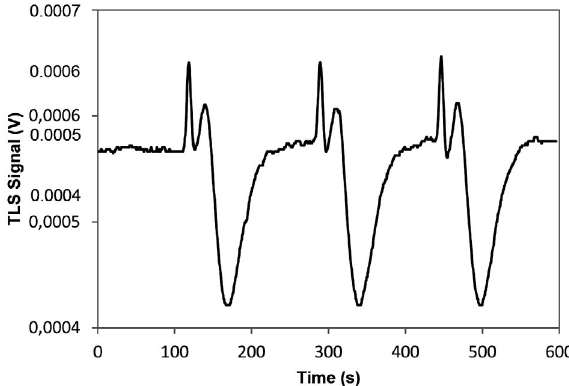
Figure 4. The shape of FIA-TLS signal peaks for 30 mM PHN used as a carrier solution